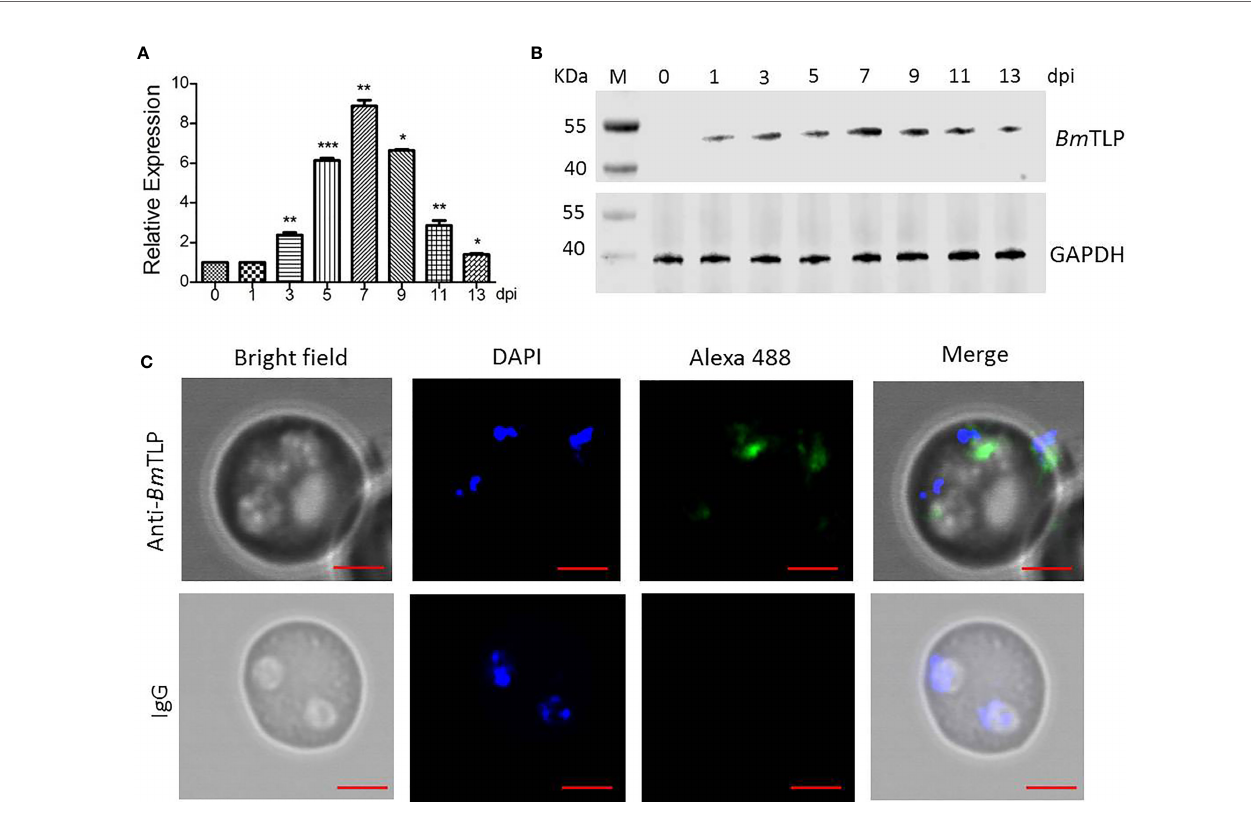
FIGURE 3 | Expression of Trx-like protein ( Bm TLP) in B. microti. B. microti parasites were collected from Babesia -infected mice 0, 1, 3, 5, 7, 9, 11, and 13 days post-infection (dpi). (A) Transcriptional expression of Bm TLP-encoding gene in B. microti parasites from infected mice detected by real-time qPCR with 18S ribosomal RNA of B. microti used as reference gene. The results are representative of three independent experiments, with data indicating mean + standard deviation. Asterisks indicate comparison with the previous group with * p < 0.05, ** p < 0.01, and *** p < 0.0001. (B) Expression of Bm TLP detected by western blot. Lane M, standard protein molecular weight marker. Lysates of parasite were detected with rabbit anti- Bm TLP serum. Glyceraldehyde-3-phosphate dehydrogenase (GAPDH) was used as internal reference. (C) Localization of Bm TLP detected by immuno fl uorescence assay. Thin blood smears were prepared with tail blood from